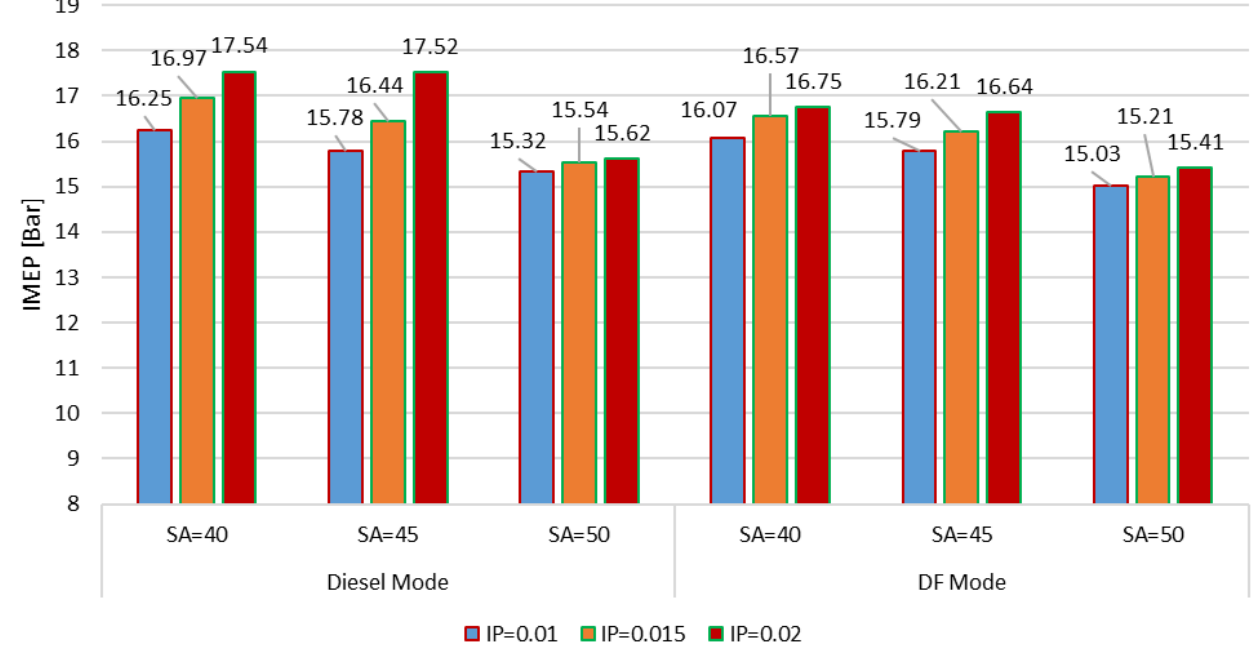
Figure 10. IMEPs of the engine in all simulation cases.